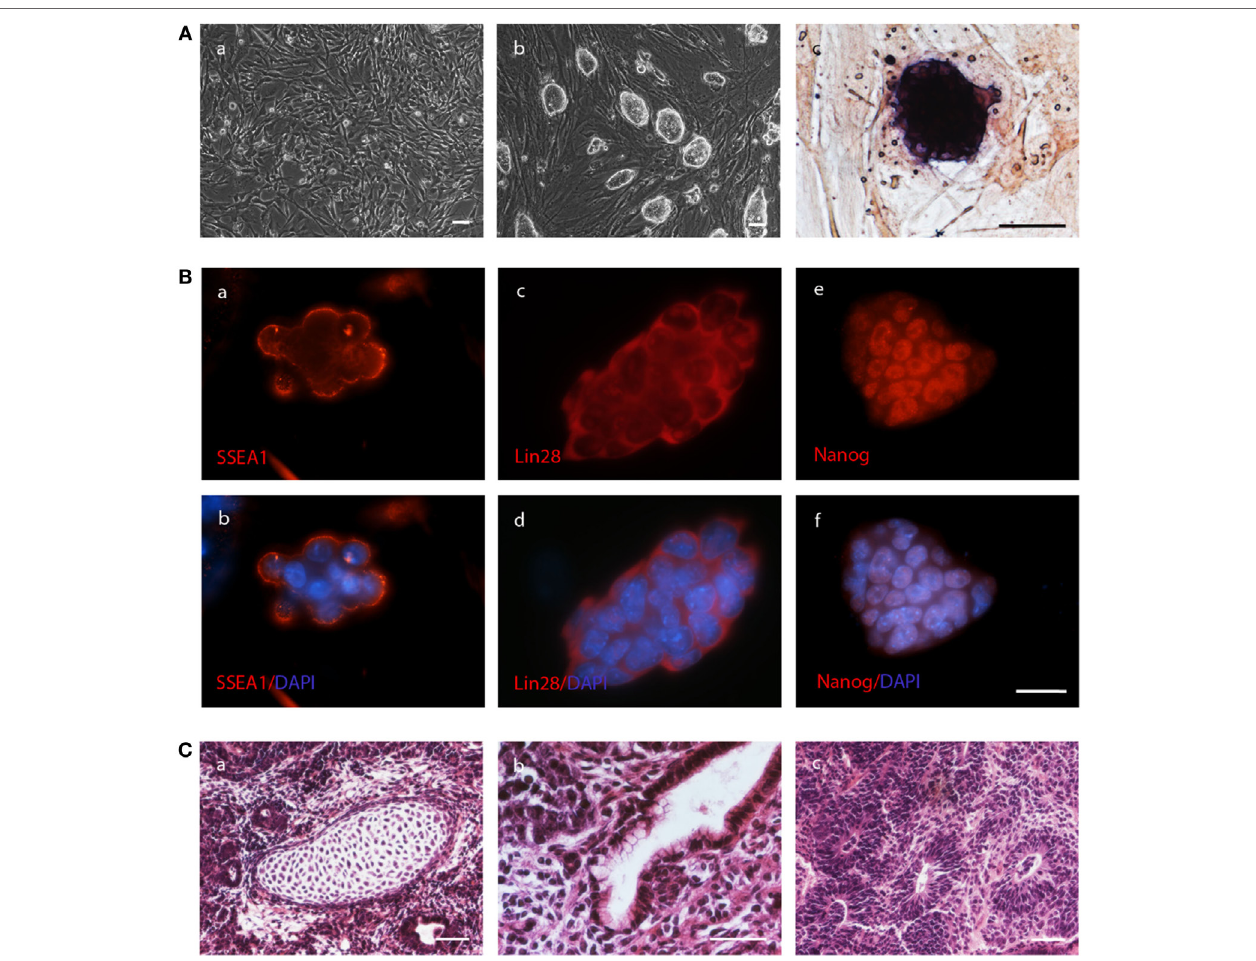
FigUre 1 | Autologous induced pluripotent stem cell (iPSC) lines are pluripotent and can give rise to teratomas. (a) Fibroblasts (a) isolated from tail tip biopsies of C57BL/6J mice gave rise to colonies of iPSCs (b) upon transduction with the reprogramming vector. The colonies were positive for alkaline phosphatase (c). The scale bars indicate 50 µm. (B) Colonies of the iPSCs also expressed the pluripotency marker proteins SSEA1 (a, b), LIN28 (c, d), and NANOG (e, f) as demonstrated by immunofluorescence staining alone (a, c, e) or in combination with DAPI to counterstain nuclei (b, d, f). The scale bar indicates 25 µm. (c) Cells of the iPSC line 1–2 were subcutaneously injected into the mouse that donated the fibroblast and a teratoma was obtained after 35 days. The mesodermal differentiation into cartilage (a), endodermal differentiation into intestinal epithelium (b), and ectodermal differentiation into neural rosettes (c) is shown. The scale bars indicate 100